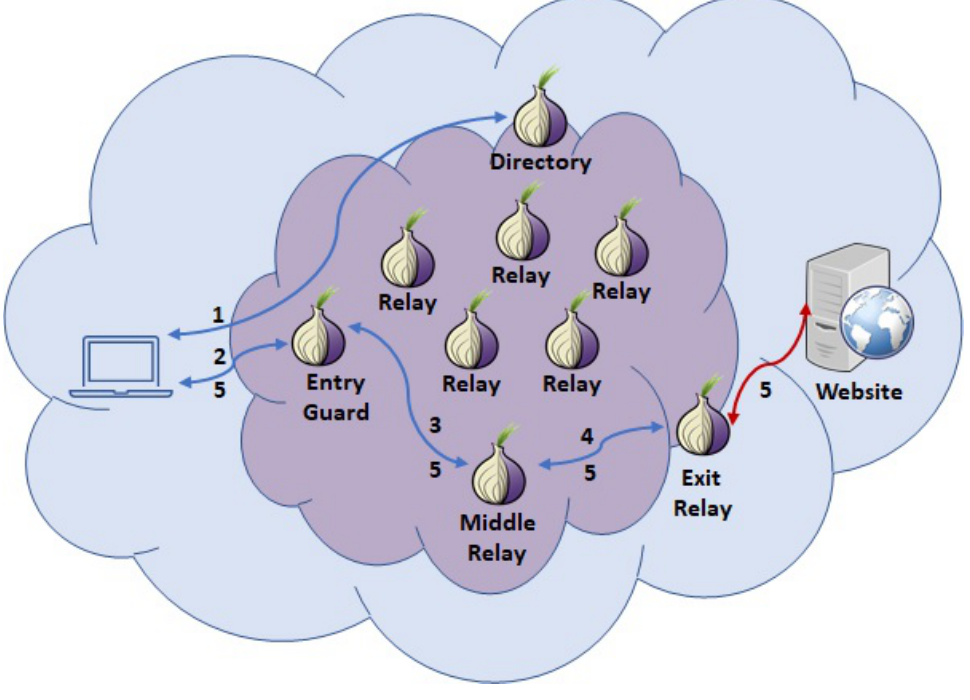
Figure 1. Tor circuit. Source: